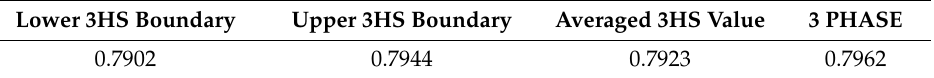
Table 8. Three-phase thermal conductivity approximations—cement system